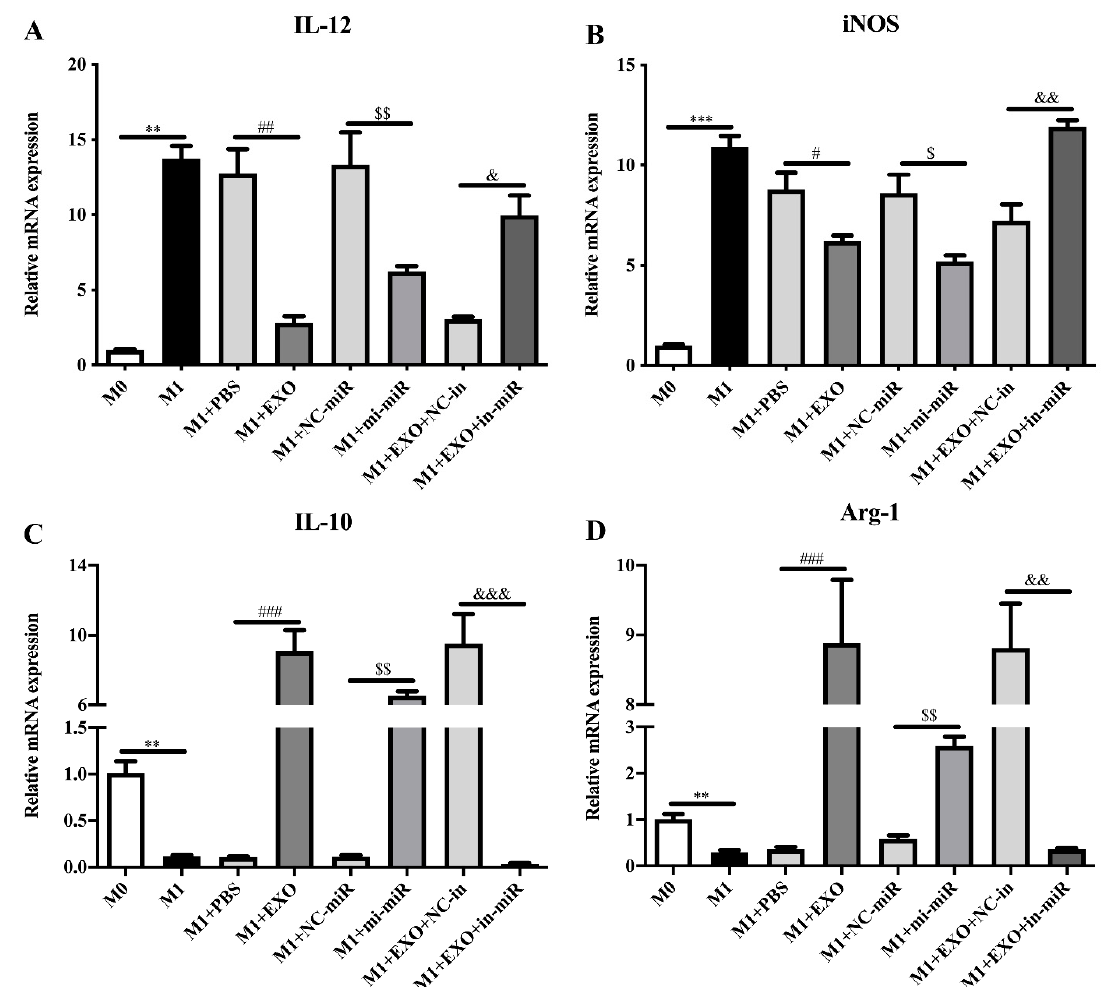
Figure 3. Exosomal miR-let-7-5p promoted M2 macrophage activation. ( A ) The expression levels of IL-12 after different treatments were determined by qPCR. ( B ) The expression levels of iNOS after different treatments were detected by qPCR. ( C ) The expression levels of IL-10 after different treatments were assessed by qPCR. ( D ) The expression levels of Arg-1 after different treatments were evaluated by qPCR. n = 3, mean ± SD, ** p < 0.01, *** p < 0.001 vs. the M0 group. # p < 0.05, ## p < 0.01, ### p < 0.001 vs. the M1+EXO group. $ p < 0.05, $$ p < 0.01, vs. the M1+mi-miR group. & p < 0.05, && p < 0.01, &&& p < 0.001 vs. the M1 + EXO + in-miR group.